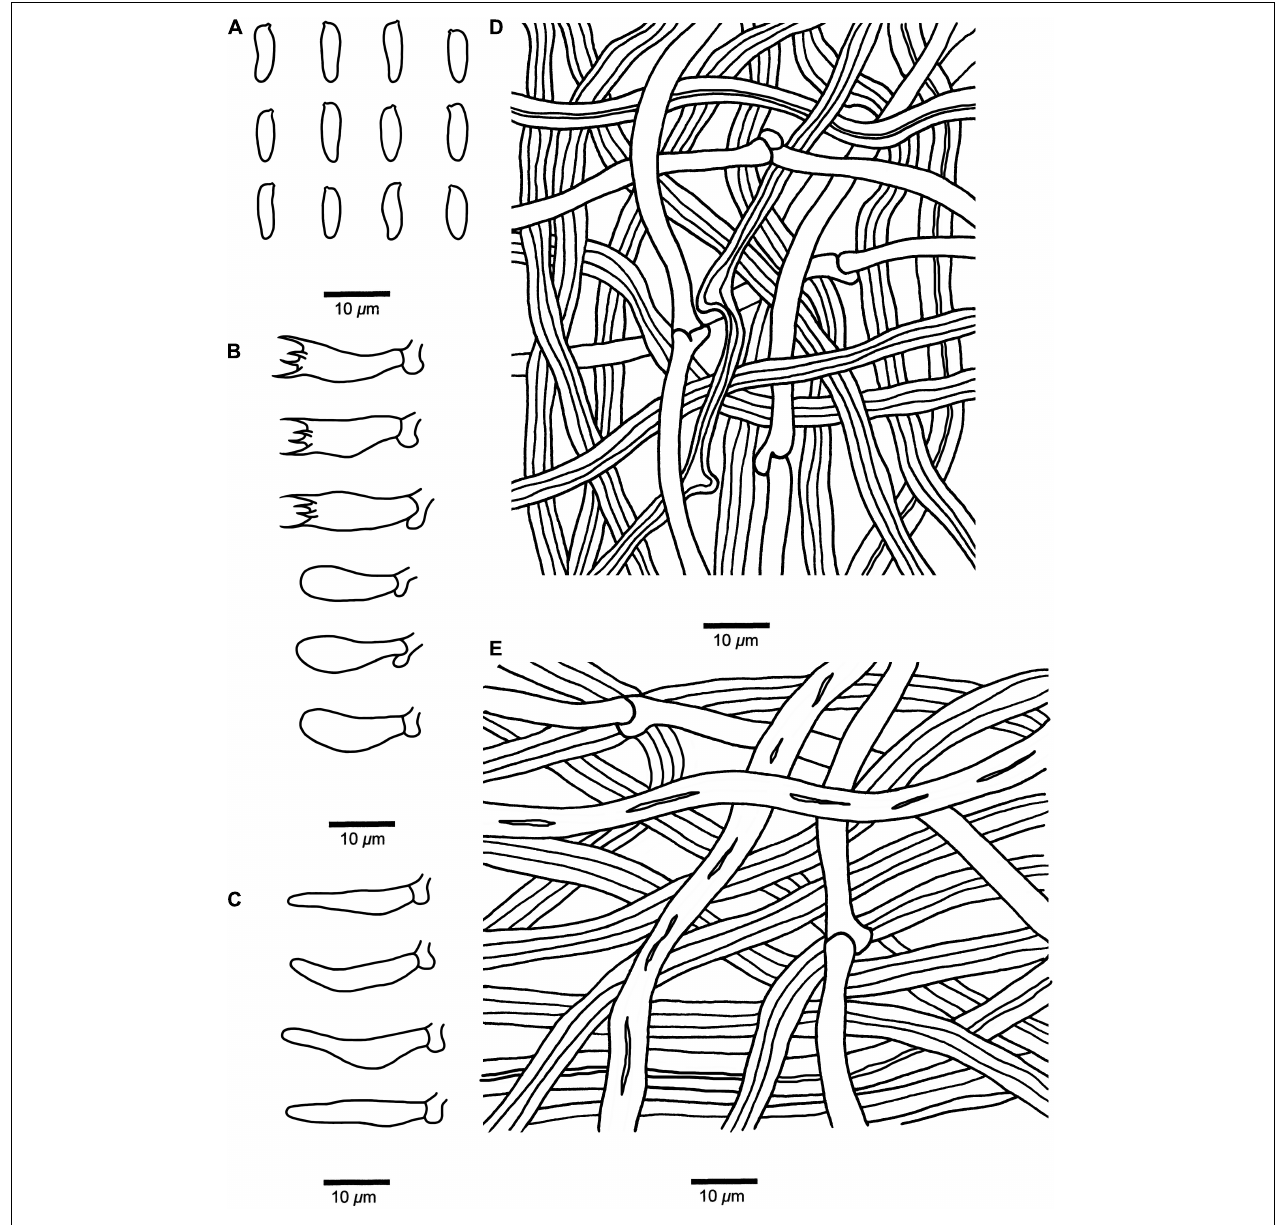
FIGURE 3 | Microscopic structures of Fomitopsis resupinata (Holotype, Dai 10819 ). (A) Basidiospores. (B) Basidia and basidioles. (C) Cystidioles. (D) Hyphae from trama. (E) Hyphae from context. Drawings by: Shun